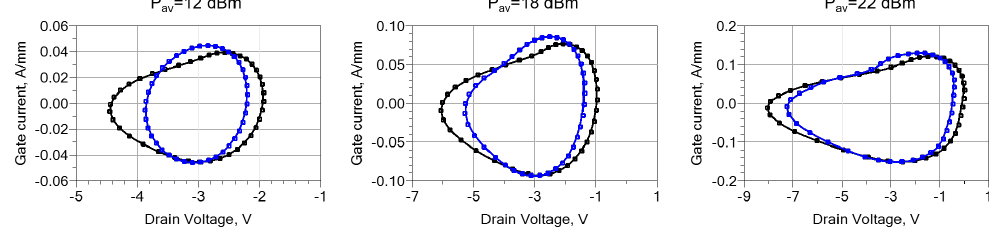
Figure 14. DLLs at the gate port from TCAD (symbols) and ADS simulations (lines): − 10% doping (black lines and symbols); +10% (blue lines and